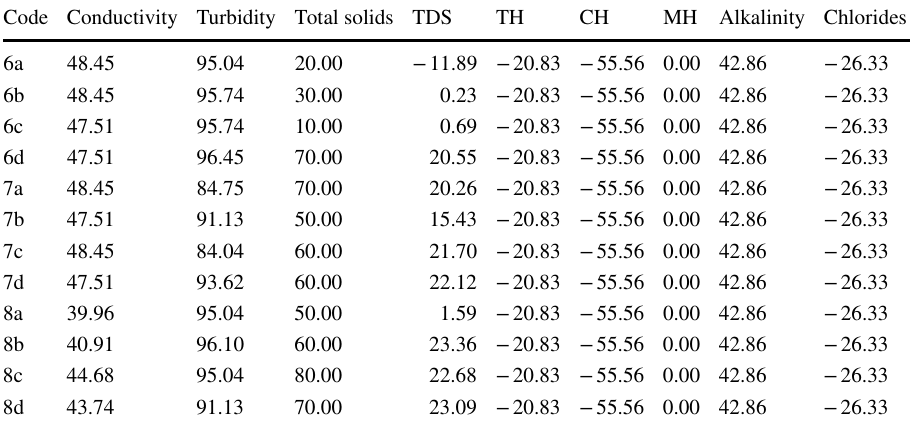
Table 11 Percentage reduction in various physicochemical parameters of surface water after treatment with blended coagulant (alum + chitin + sago—1:2 ratio)